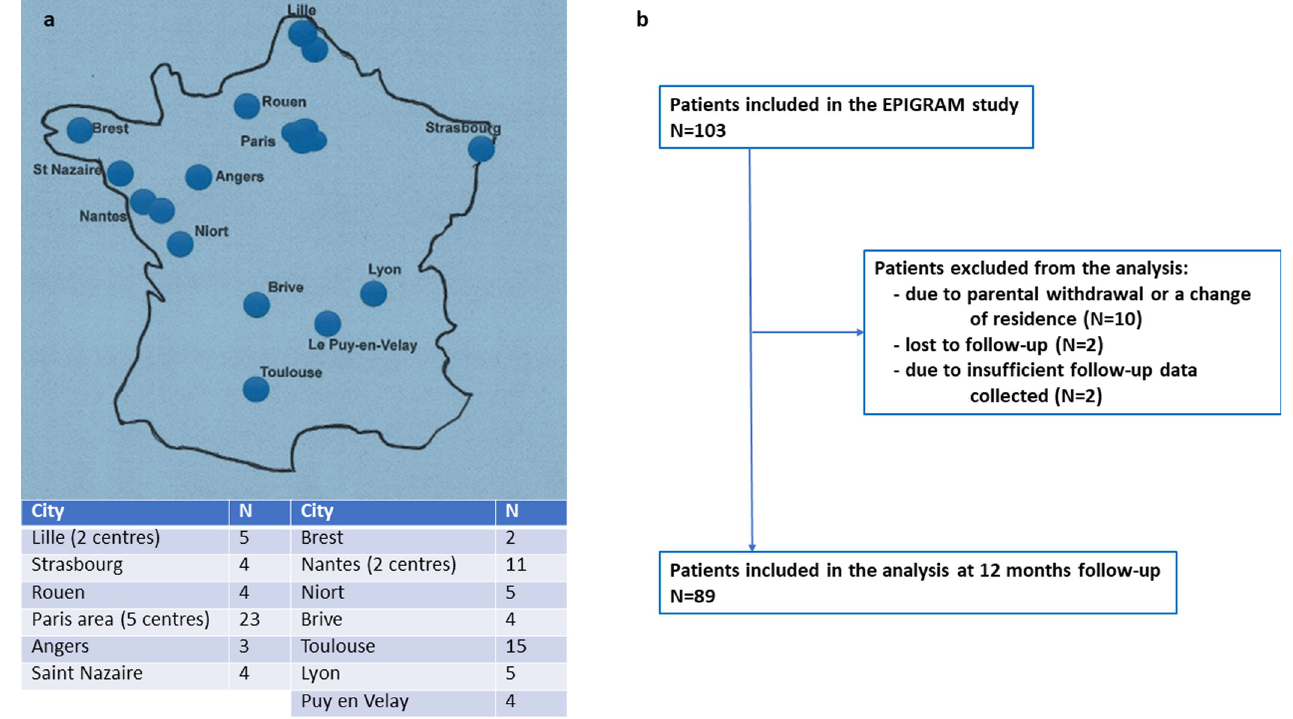
Fig 1. EPIGRAM study: Site location in France (1a) and diagram flow